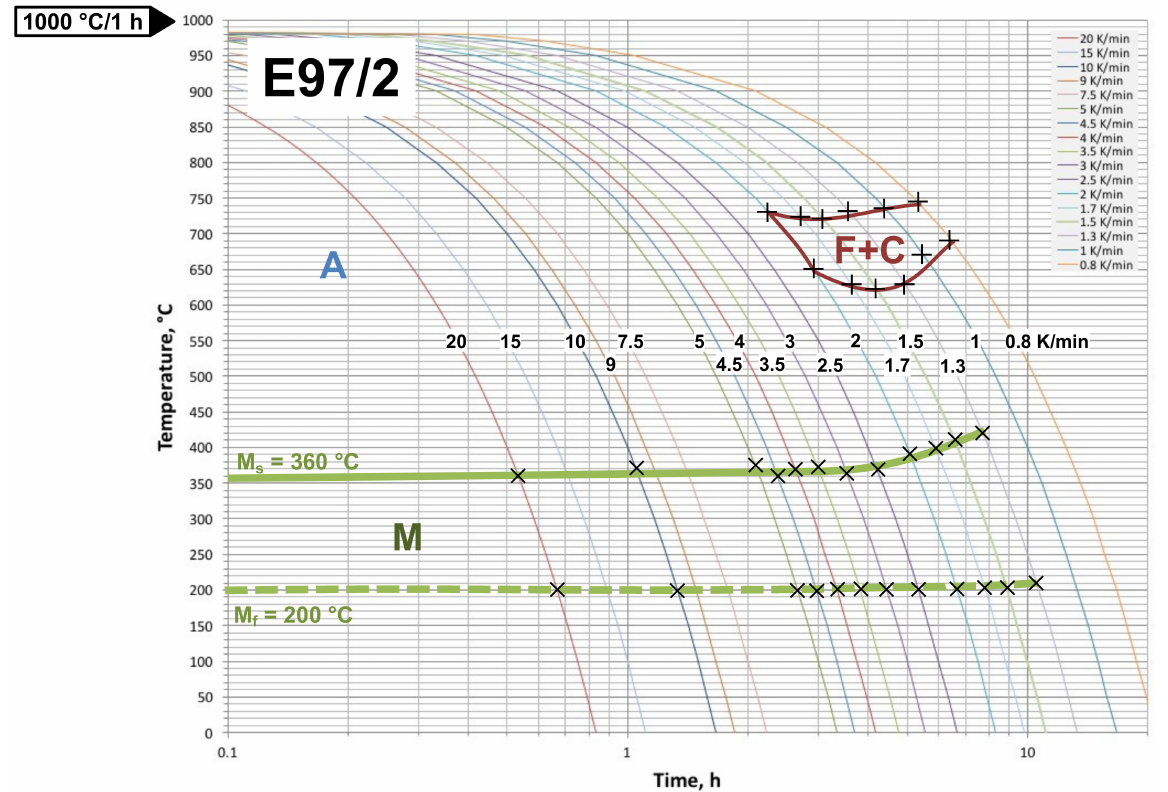
Figure 1. Time Temperature Transition (TTT) diagram for EUROFER97/2 after austenitization for 60 min at 1000 ◦ C. The lines correspond to cooling by different rates (note the logarithmic time scale). The phases that form during cooling are denoted: austenite A, martensite M, ferrite F, carbide C. Start and end of martensite formation M s and M f . The crosses symbolize data determined by